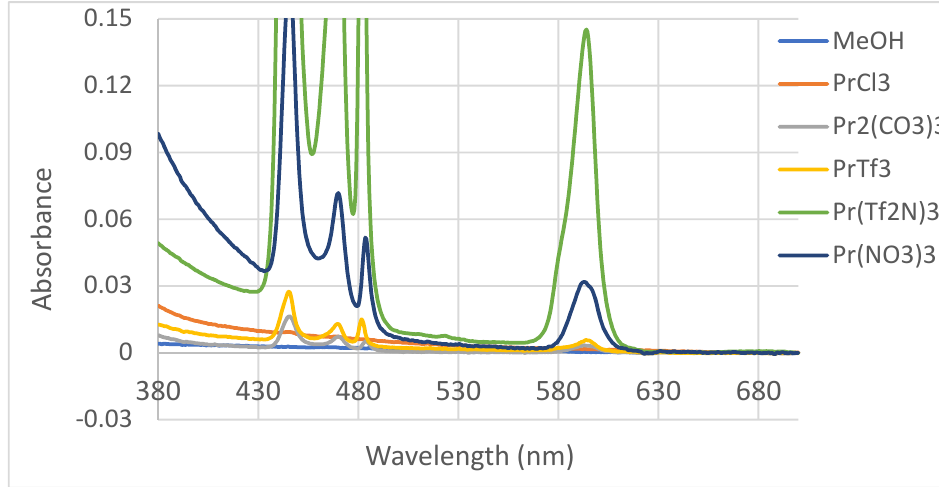
Figure 2. Absorbance spectra of several Pr salts in the visible region .